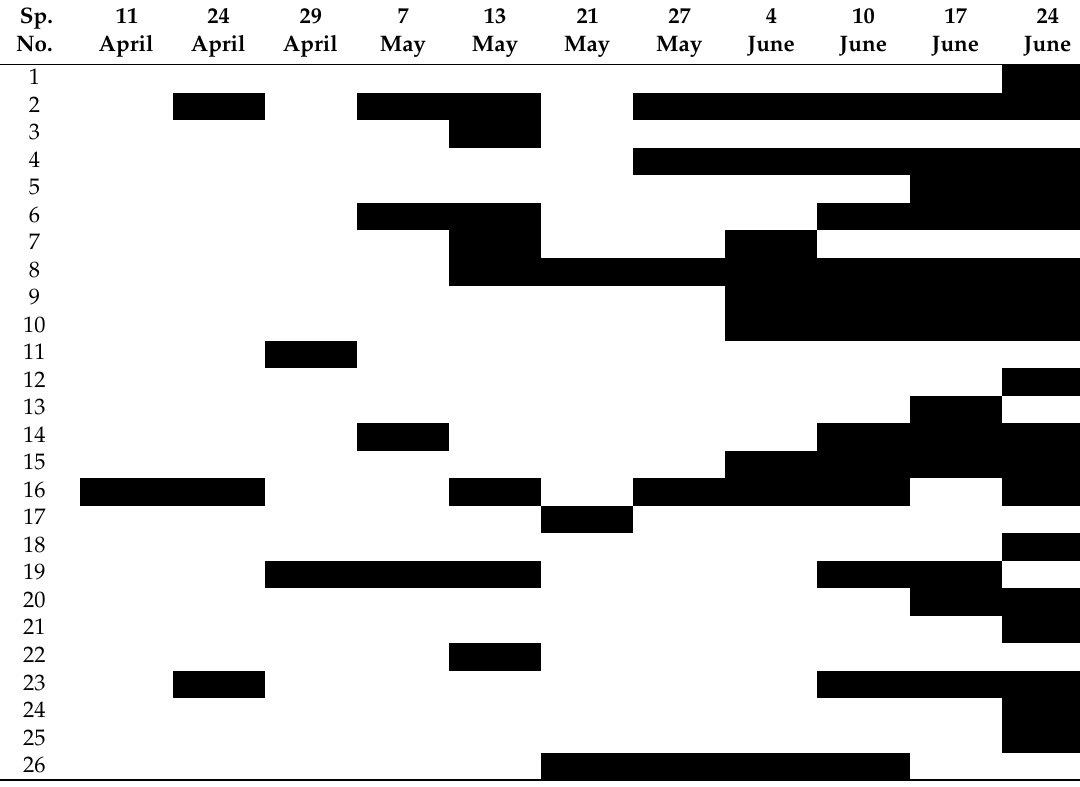
Table 2. Table of presence/absence of species found in each sampling.